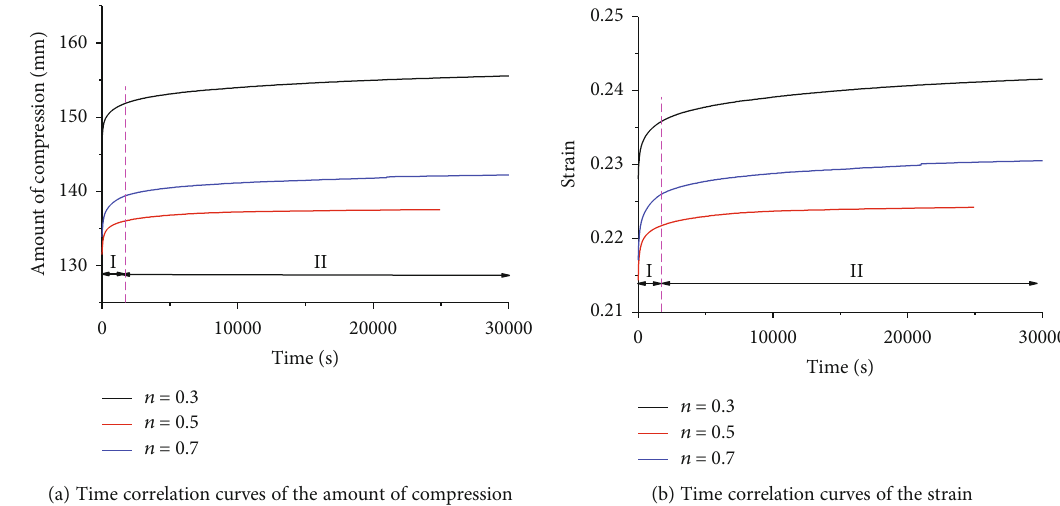
Figure 9: Time correlation curves of the amount of compression and strain for caving crushed sandstone samples of di ff erent grain compositions (axial stress of 3.5